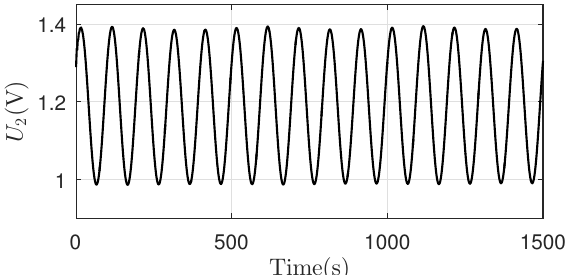
Figure 9. Control input U 2 in submerging motion with a variable velocity and constant pitch angle